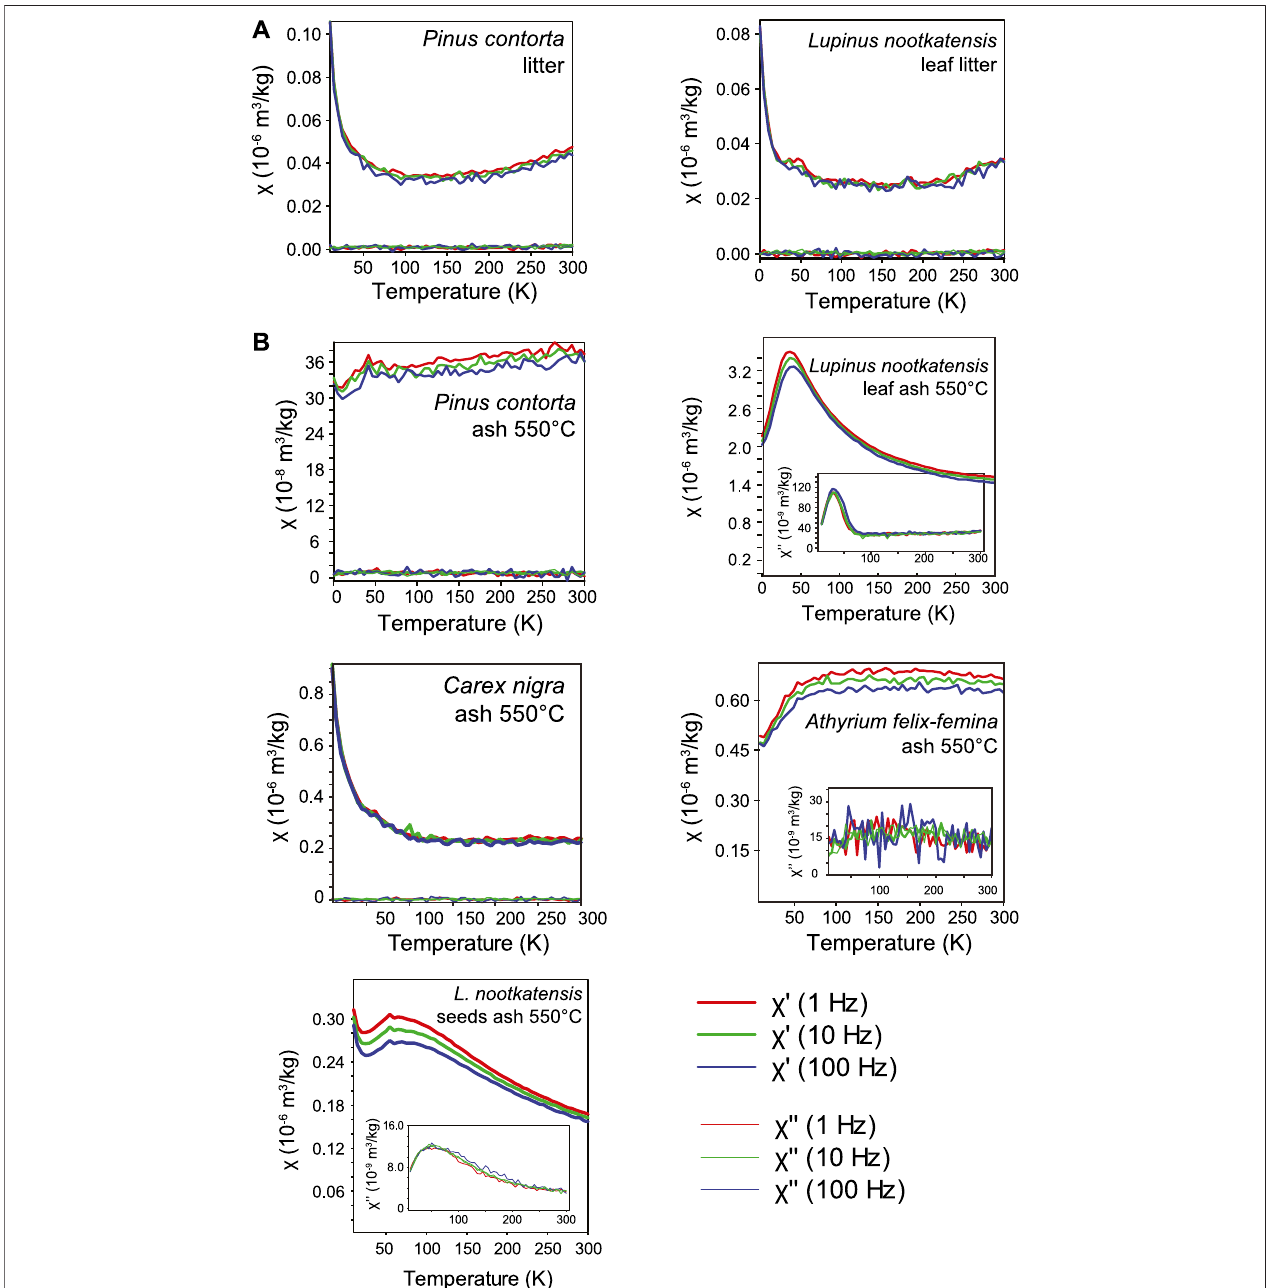
FIGURE 3 | Low-temperature measurements of (A) FC-ZFC and RTSIRM remanence and (B) frequency-dependent susceptibility for German char and ash samples.